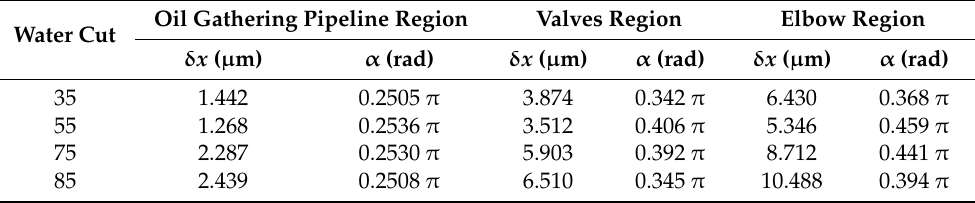
Table 1. Deformation characteristic parameters of dispersed droplet in different flow region.